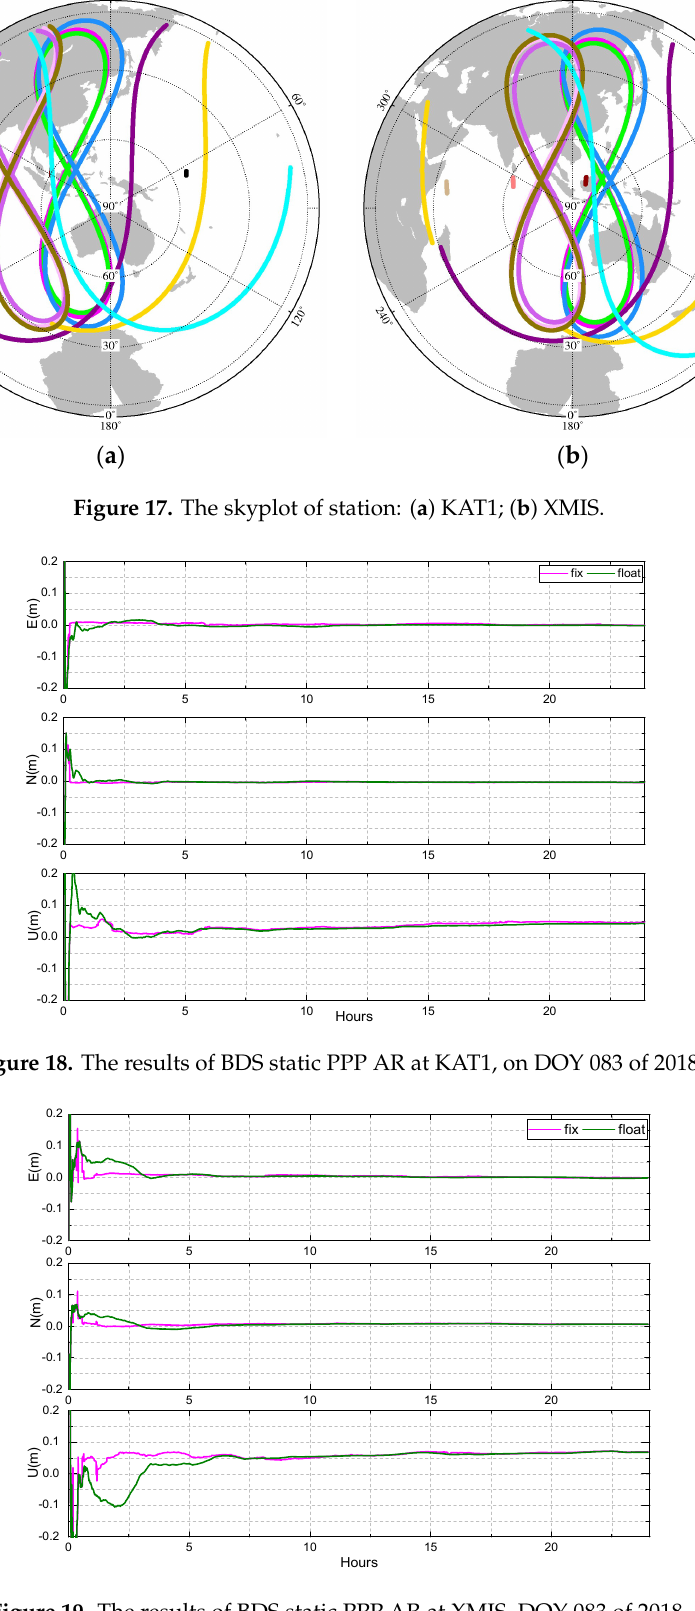
Figure 19. The results of BDS static PPP AR at XMIS, DOY 083 of 2018. The result of the fixed solution converges rapidly in east, north, and up directions when the ambiguity is fixed. After convergence, the horizontal accuracy of the fixed solution is less than 1 cm,